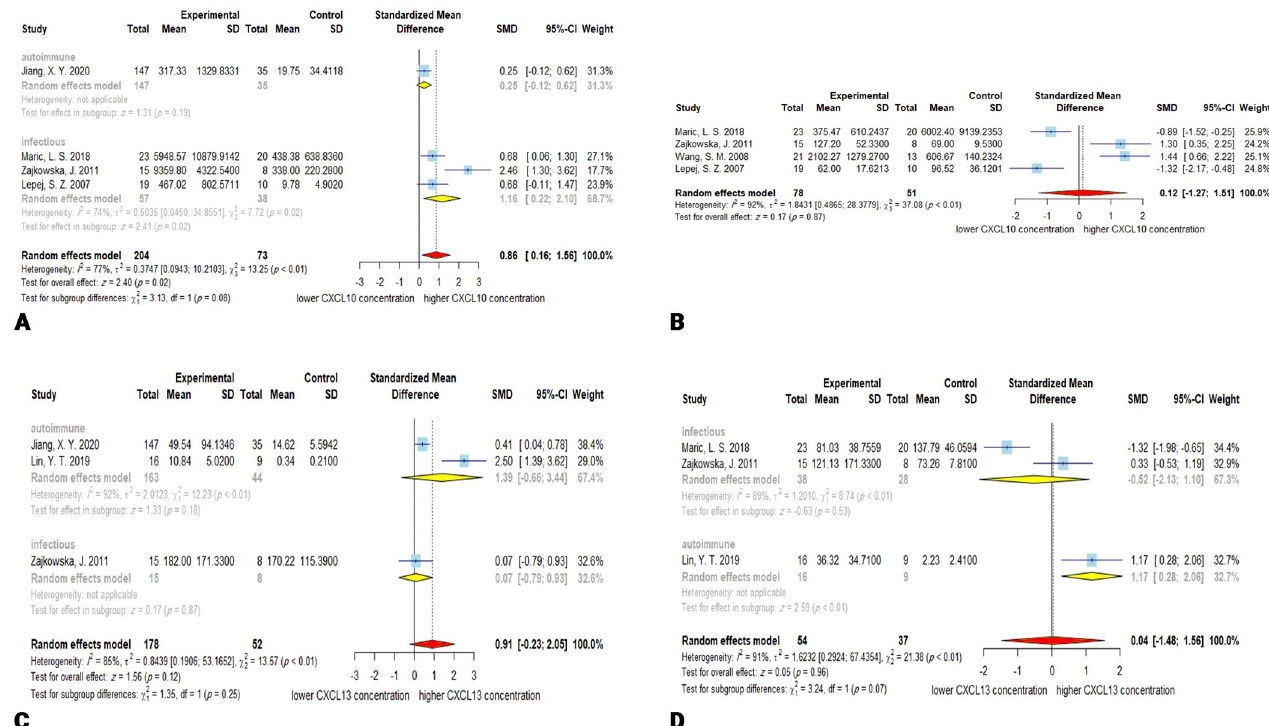
Fig 5. Forest plots for results of the meta-analysis for CXCL10 CSF concentrations (A) , CXCL10 serum/plasma concentrations (B) , CXCL13 CSF concentrations (C) , and CXCL13 serum/plasma concentrations (D) . SD, standard deviation; SMD, standardized mean difference; CI, confidence interval.